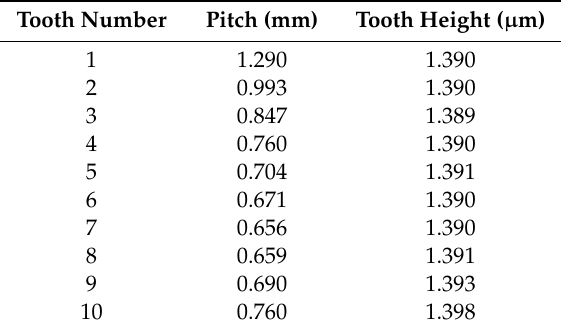
Figure 7. Feature size of a DOE. Table 1. The nominal tooth profile information of a DOE.